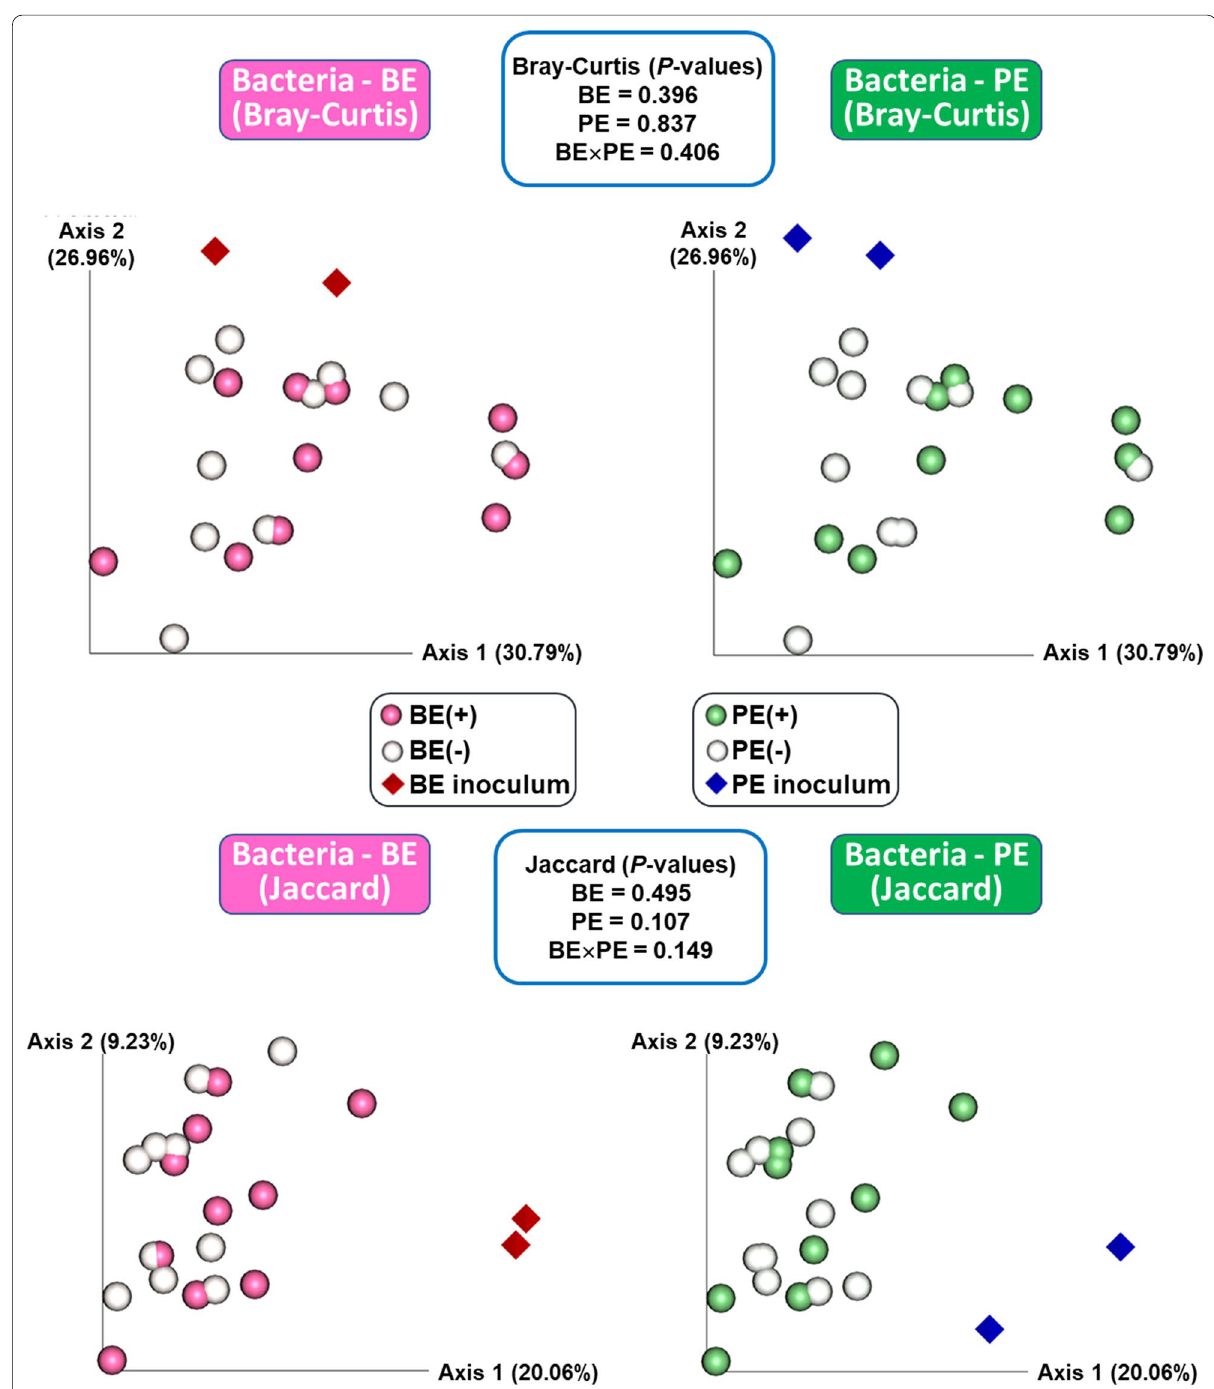
Fig. 2 Principal coordinates analysis (PCoA) plot based on Bray–Curtis and Jaccard distance matrices representing overall rumen bacterial microbiota at the genus level in the liquid fraction of dairy calves differed by microbial inoculations with two types of inocula (BE and PE). BE, bacterial-enriched rumen fluid; PE, protozoal-enriched rumen